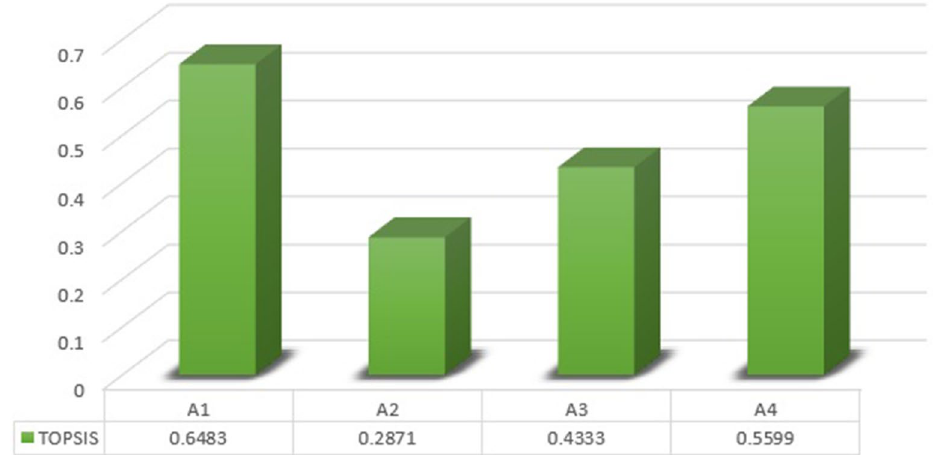
Figure 2. The graphical representation of ranking under TOPSIS